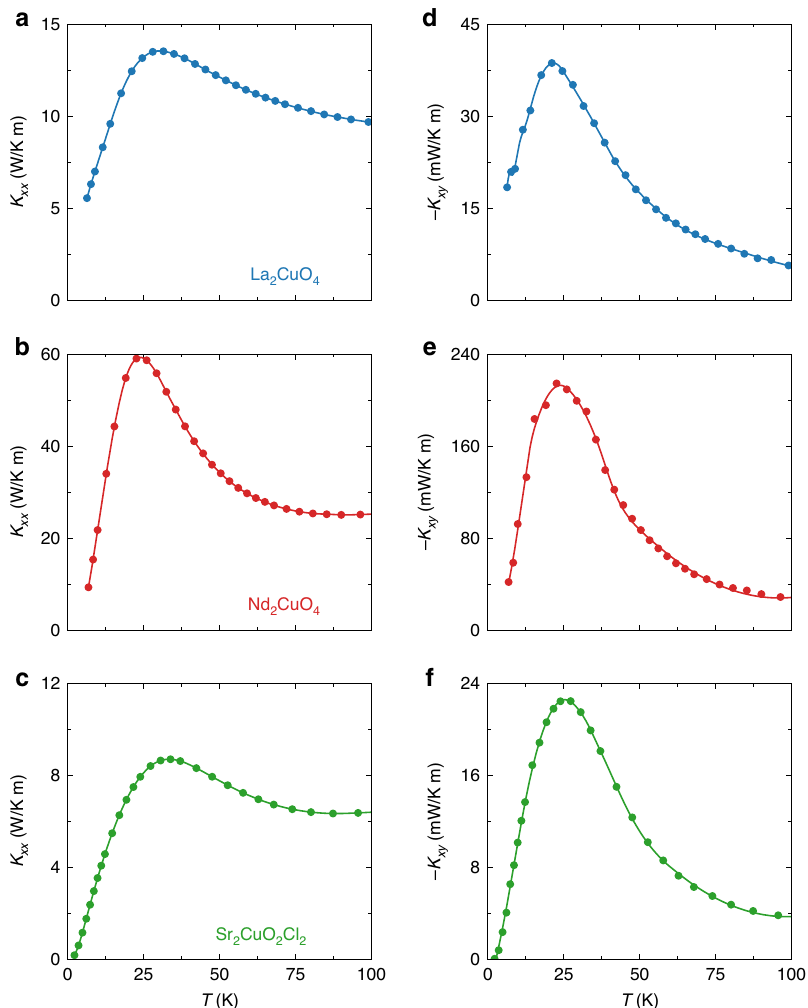
Fig. 3 Thermal Hall conductivity in the three Mott insulators. Left panels: thermal conductivity of the three cuprate Mott insulators, plotted as κ xx vs T : a La 2 CuO 4 , b Nd 2 CuO 4 , and c Sr 2 CuO 2 Cl 2 . Right panels: Corresponding thermal Hall conductivity, plotted as − κ xy vs T : d La 2 CuO 4 , e Nd 2 CuO 4 , and f Sr 2 CuO 2 Cl 2 . All data shown in this fi gure are taken in a fi eld of 15 T (along the c